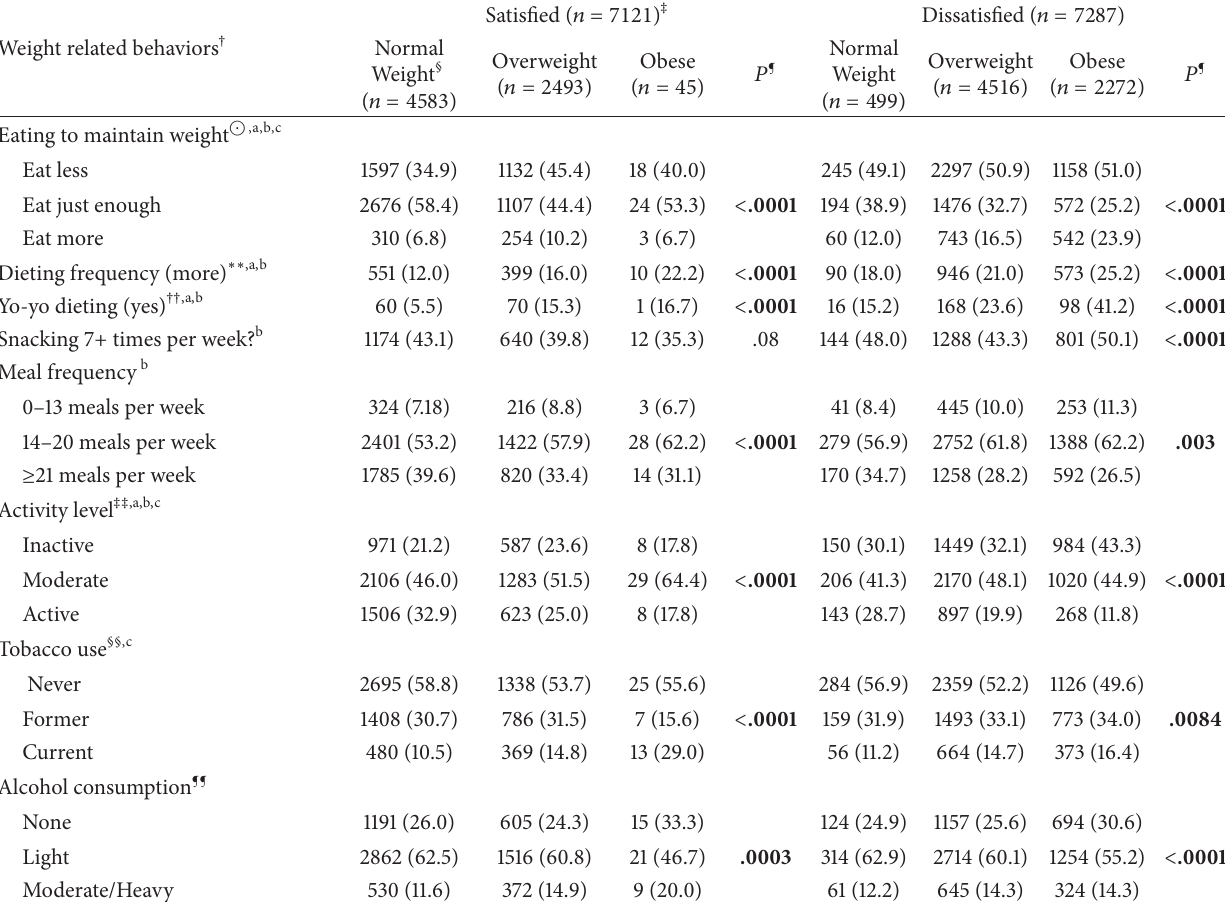
Table 3: Relationships between body weight satisfaction by overweight status and weight-related health behaviors, Aerobics Center Longitudinal Study, 1987–2002: men ( 𝑛 = 14,408 ) ∗